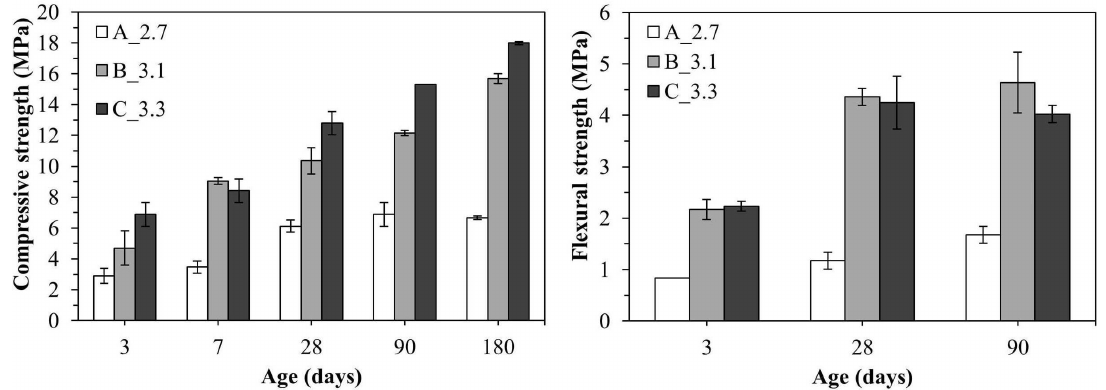
Figure 9. Compressive (a) and flexural (b) strengths of mortars made with the one-part